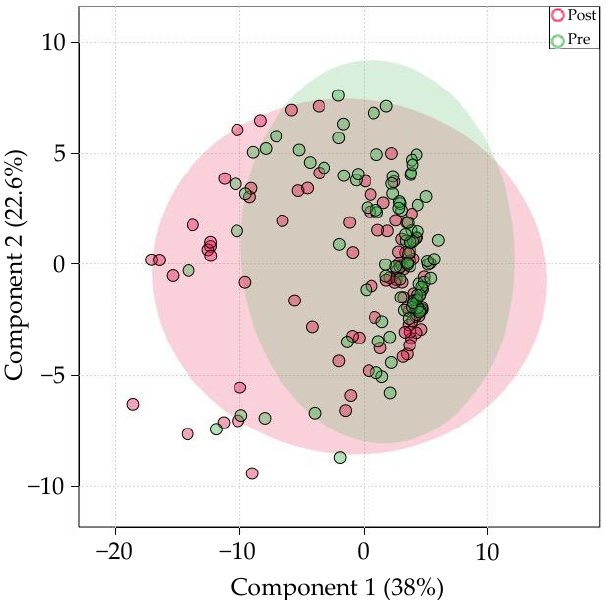
Figure 5. Differences in exercise state confer minimal miRNA variation. PLS-DA plot of pre- (green) and post-exercise (red) samples.